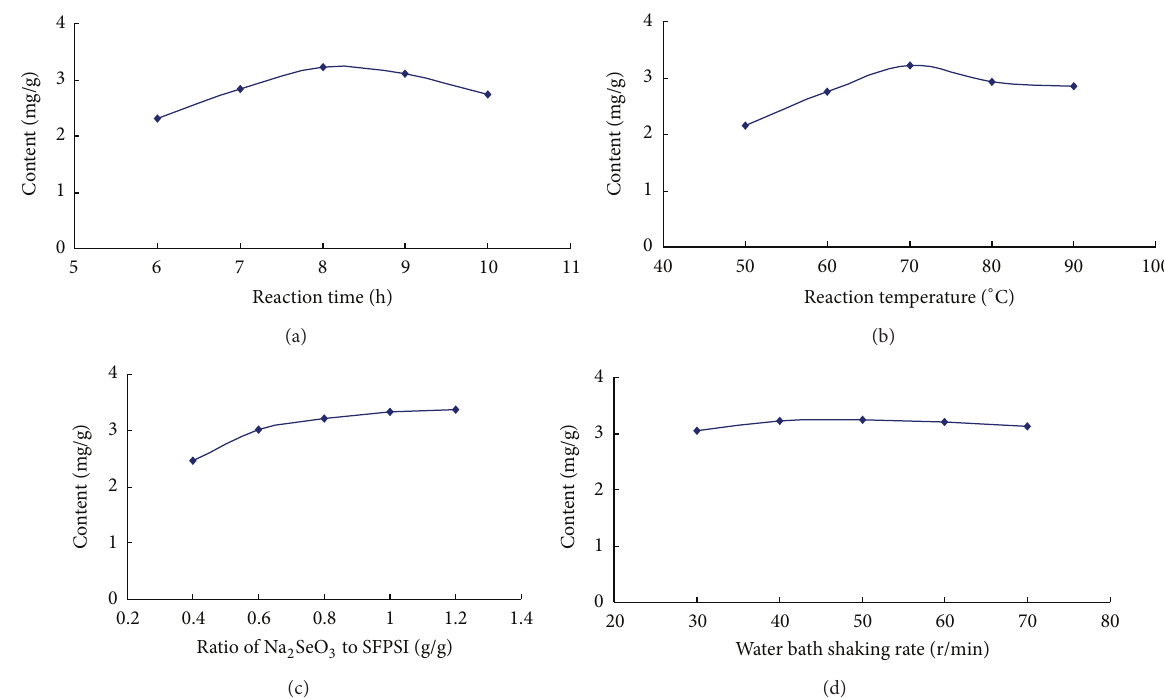
Figure 1: Effect of reaction time, temperature, ratio of Na 2 SeO 3 to SFPSI, and water bath shaking rate on Se content. (a) Reaction temperature 70 ∘ C, ratio of Na 2 SeO 3 to SFPSI 0.8 g/g, and water bath shaking rate 40r/min; (b) reaction time 8h, ratio of Na 2 SeO 3 to SFPSI 0.8g/g, and water bath shaking rate 40r/min; (c) reaction time 8h, reaction temperature 70 ∘ C, and water bath shaking rate 40 r/min; (d) reaction time 8h, reaction temperature 70 ∘ C, and ratio of Na 2 SeO 3 to SFPSI 0.8